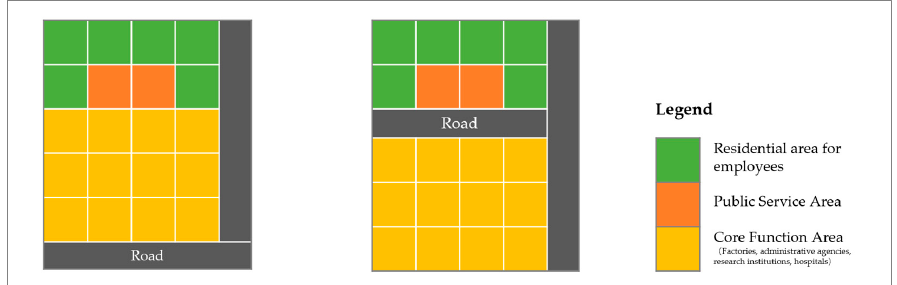
Table 1. Main functional zoning of the danwei community.